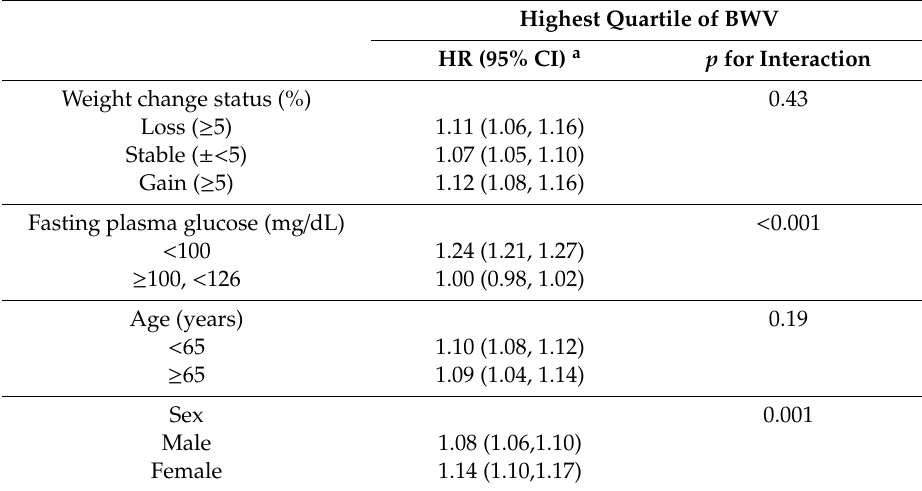
Table 3. Subgroup analysis of the risk of new-onset diabetes for subjects in the highest quartile of body weight variability compared with those in the lowest three quartiles of variability.